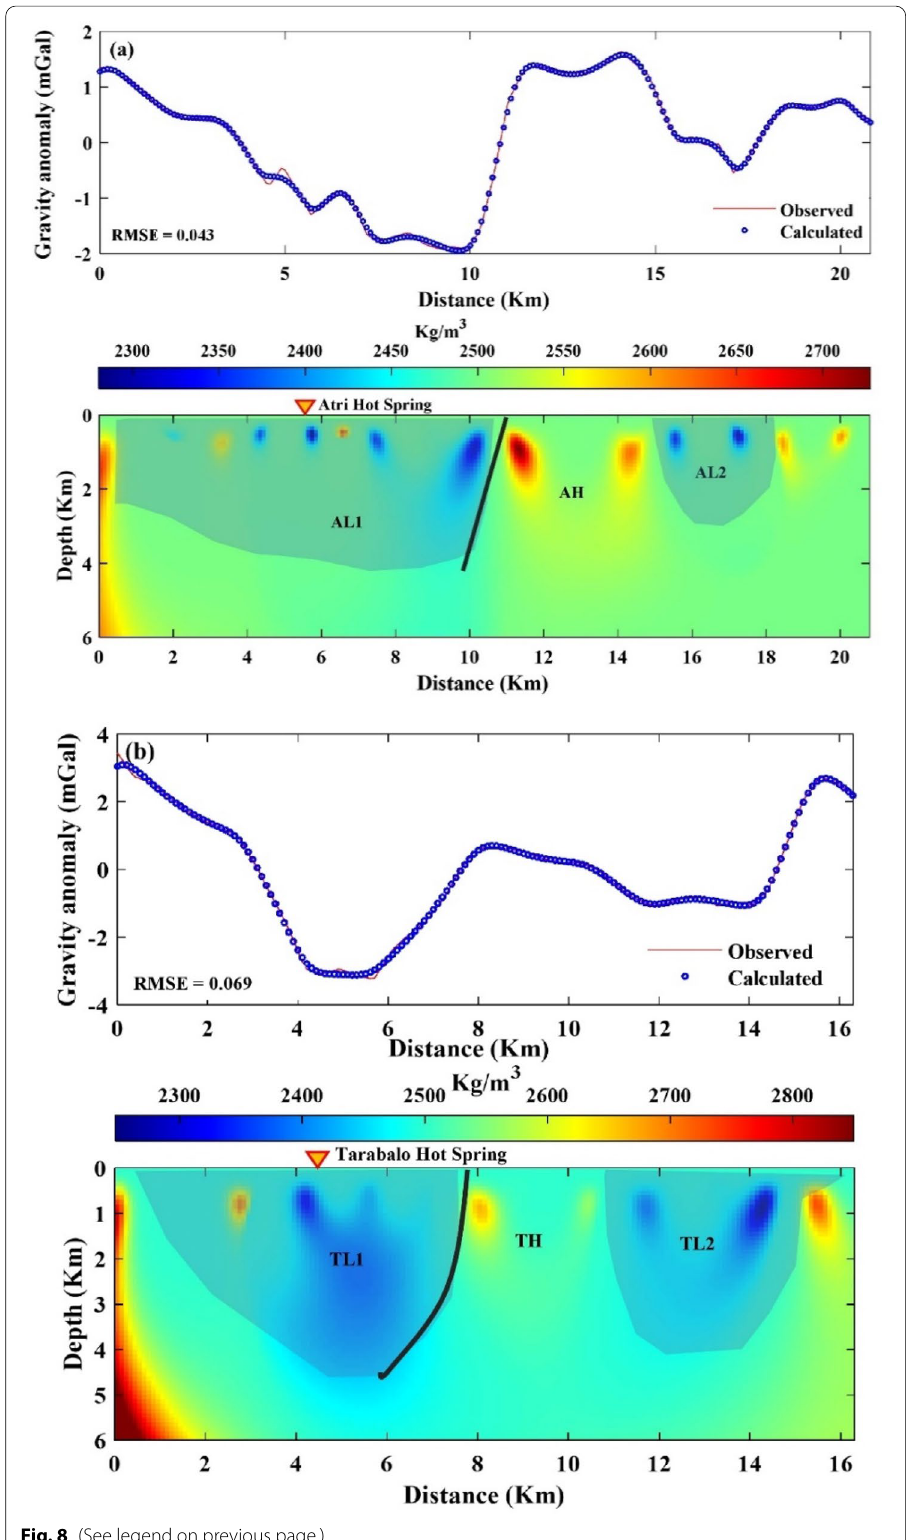
Fig. 8 (See legend on previous